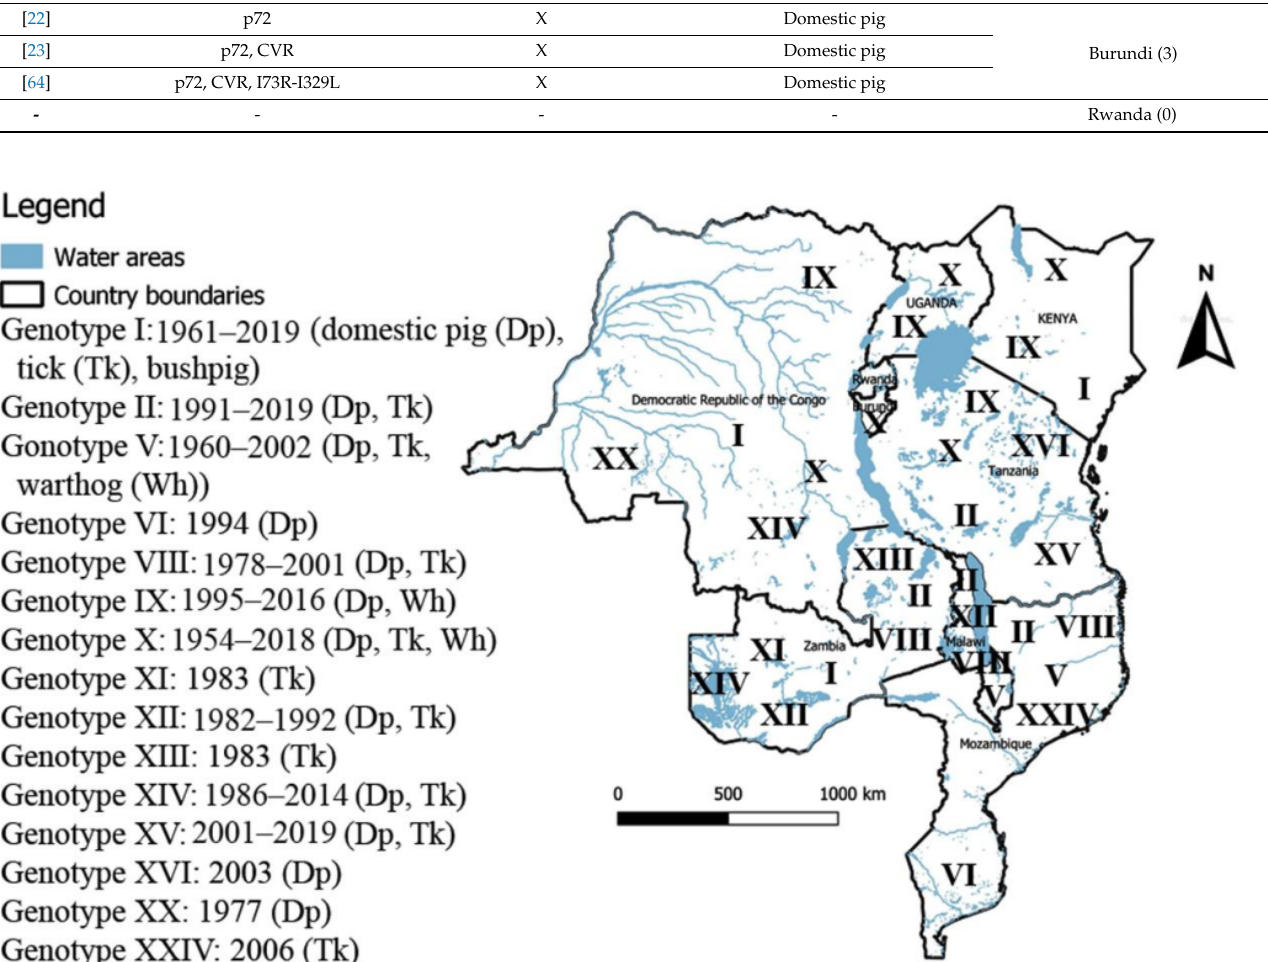
Figure 2. Distribution of the ASFV p72 genotypes circulating between Tanzania and its eight neighboring countries by October 2020. The map was developed using QGIS version 3.4.4